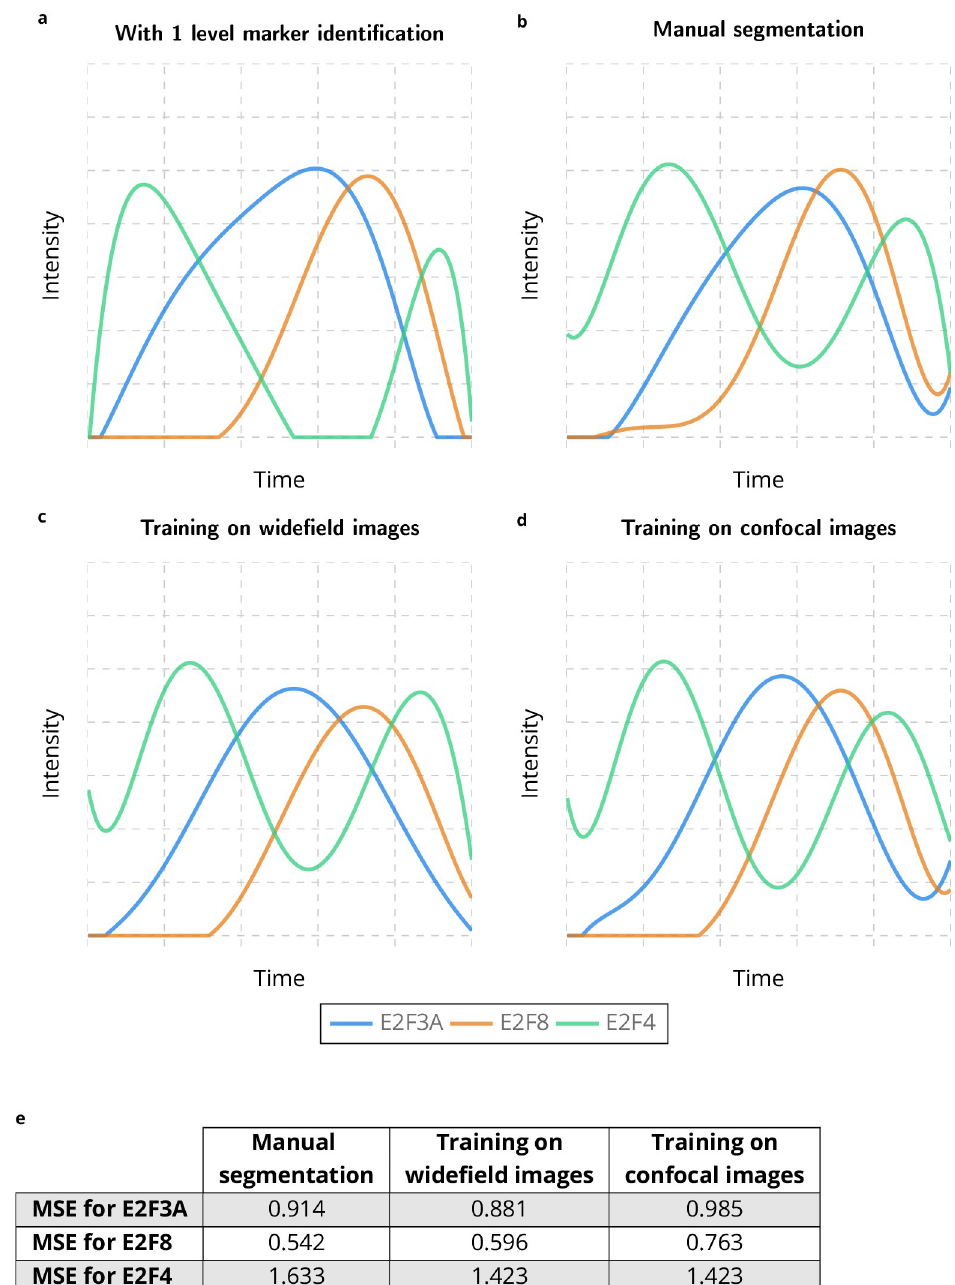
Fig 5. Estimation of E2Fs accumulation over the cell cycle without marker identification with respect to nuclei segmentation. Temporal evolution of E2F3A, E2F8 and E2F4 protein accumulation over the cell cycle in mouse intestinal epithelium, by considering positive/negative states for EdU and pH3 a , by only considering intensity for E2Fs, EdU and pH3 with a manual segmentation for nuclei b , with a nuclei segmentation obtained for the confocal images with a Mask R-CNN model trained with the widefield images and a manual segmentation for the widefield images c , and with a nuclei segmentation obtained for the widefield images with a Mask R-CNN model trained with the confocal images and a manual segmentation for the confocal images d